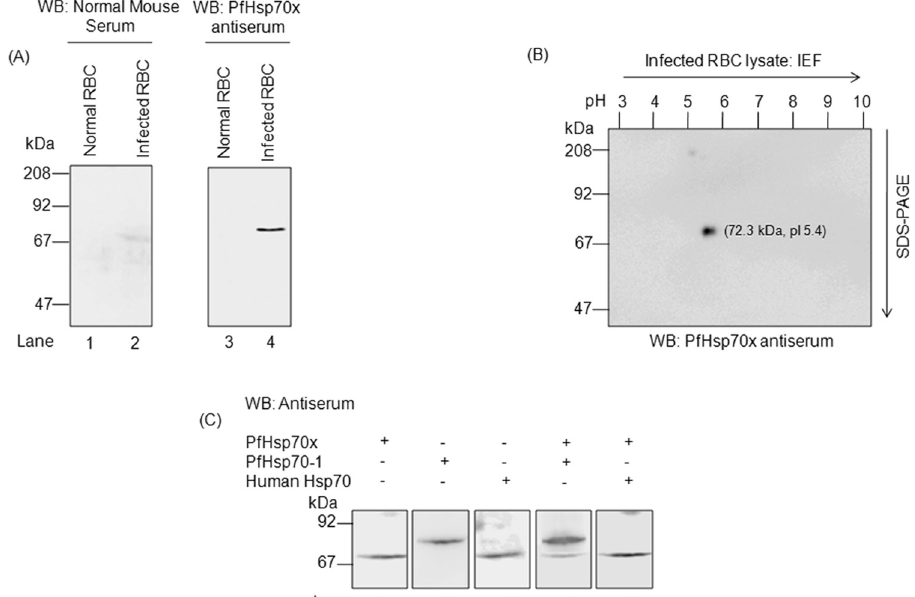
Figure 3. Specificity of PfHsp70-x antiserum : (A) Total lysates from normal and infected erythrocytes analysed by immunoblotting with normal mouse serum (left) and PfHsp70- x antiserum (right). (B) Two-dimensional electrophoresis performed using lysate from parasite infected erythrocytes and probed with PfHsp70- x antiserum. (C) Lysates from infected erythrocytes analysed by immunoblotting with other host and parasite heat shock protein antisera. Lane 1: probed with PfHsp70- x antiserum, Lane 2: probed with PfHsp70-1 antiserum, Lane 3: probed with Host Hsp70 antiserum, Lane 4: probed with both PfHsp70- x and PfHsp70-1 antiserum and Lane 5: probed with both PfHsp70- x and Host Hsp70 antiserum. The blots indicate that PfHsp70- x antiserum is specific and does not cross-react with any other host or parasite chaperone.